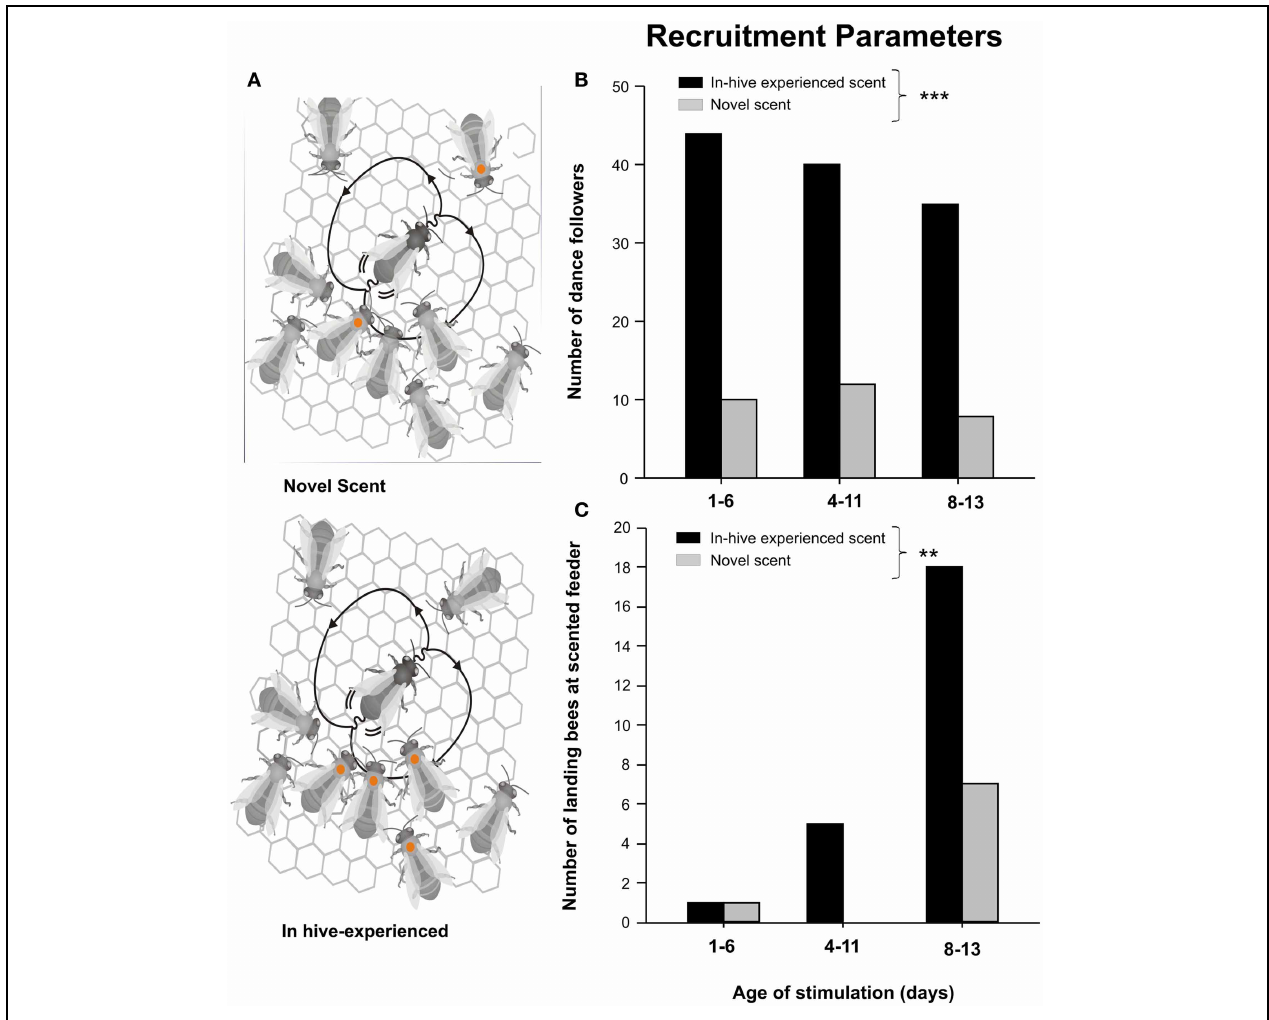
foragers. (C) Number of arrivals to the foraging location advertised by dancers carrying either the experienced scent or a novel scent. The asterisks indicate statistical differences between situations (number of dance followers: ∗∗∗ p < 0 . 001, after GLMM test; arrivals: ∗∗ p < 0 . 01, after Fisher’s exact test). (After Balbuena et al., 2012. With